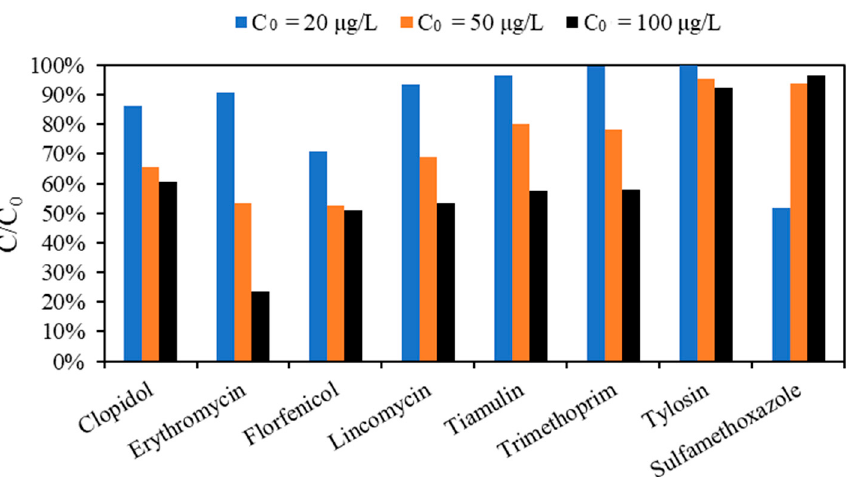
Figure 6. Effects of antibiotics concentration using UV/TiO 2 photocatalysis for 30 min: High degra- dation efficiency at low initial concentration of antibiotics.